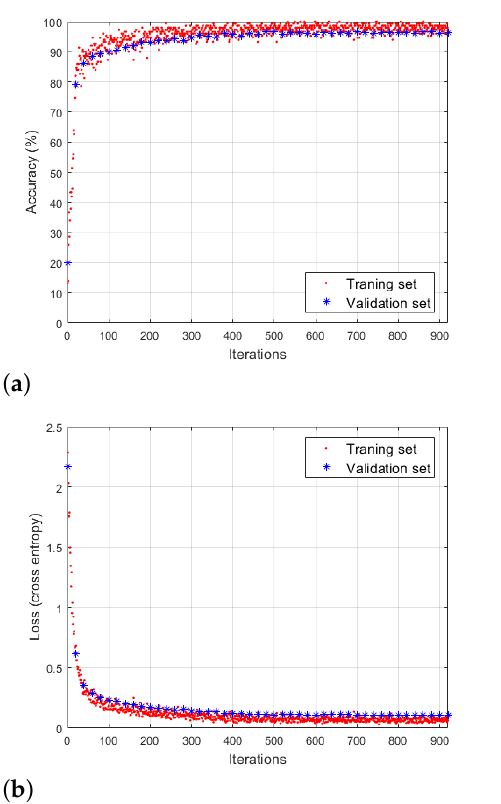
Figure 12. Performance evaluation of the CNN-based classifier used in Case 1: ( a ) Classification accuracy. ( b ) Loss